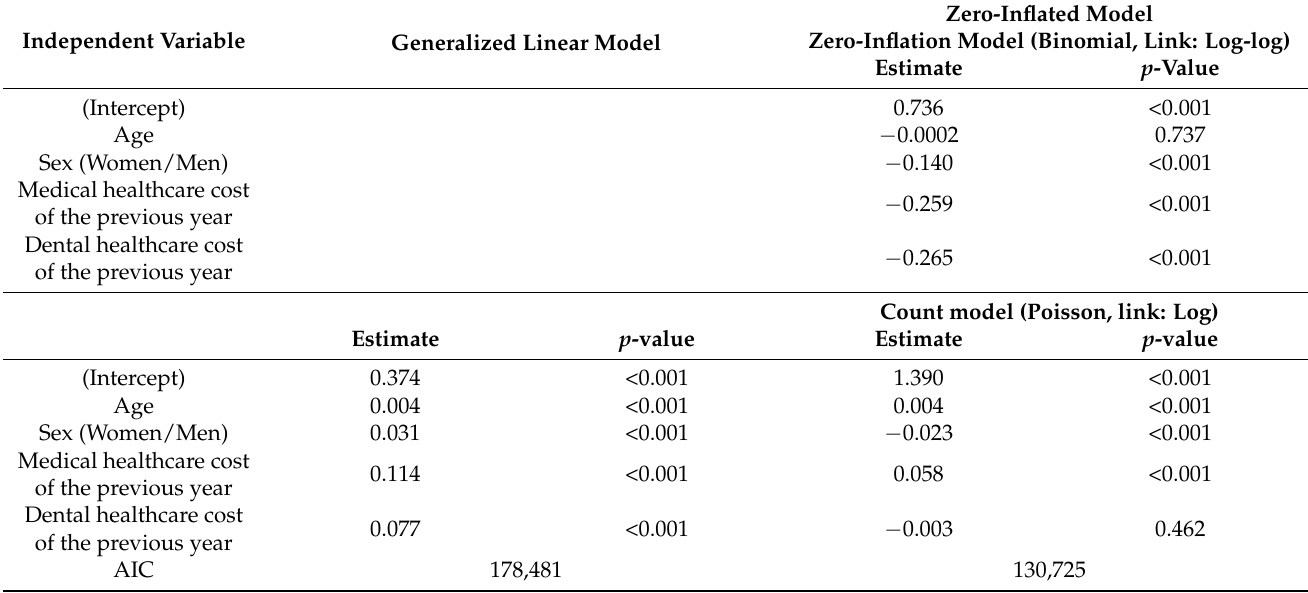
Table 1. Results of the regression model to estimate the medical healthcare cost.